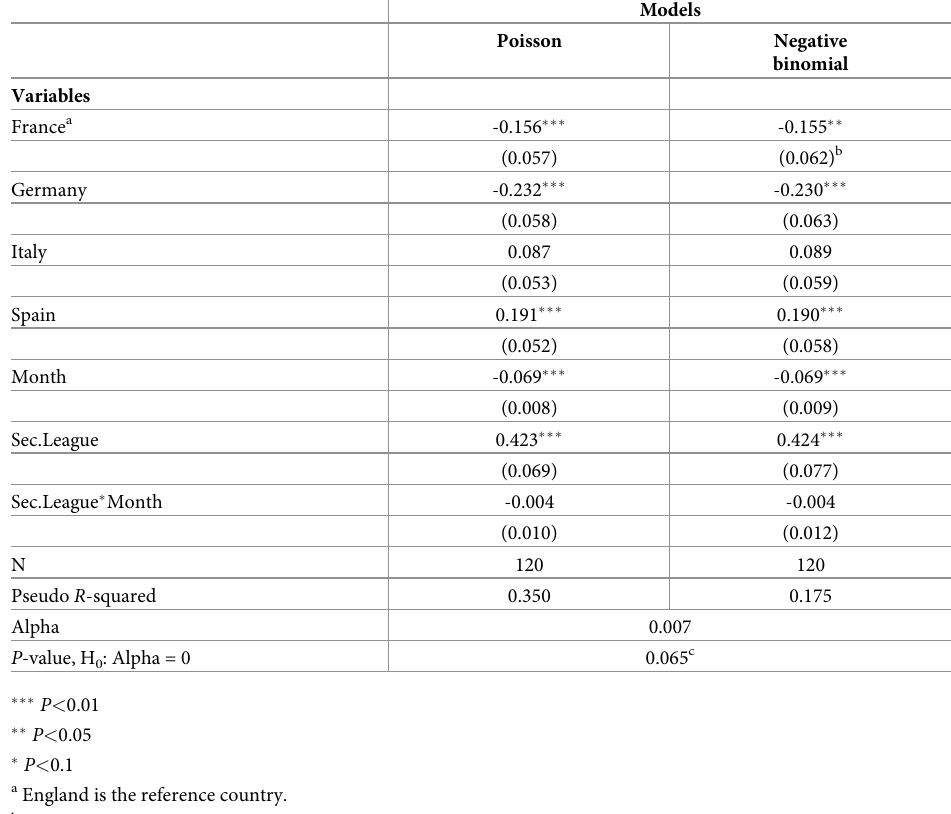
Table 2. RAE on frequency of month of birth in the first- and second-tiers of the five most important European leagues.